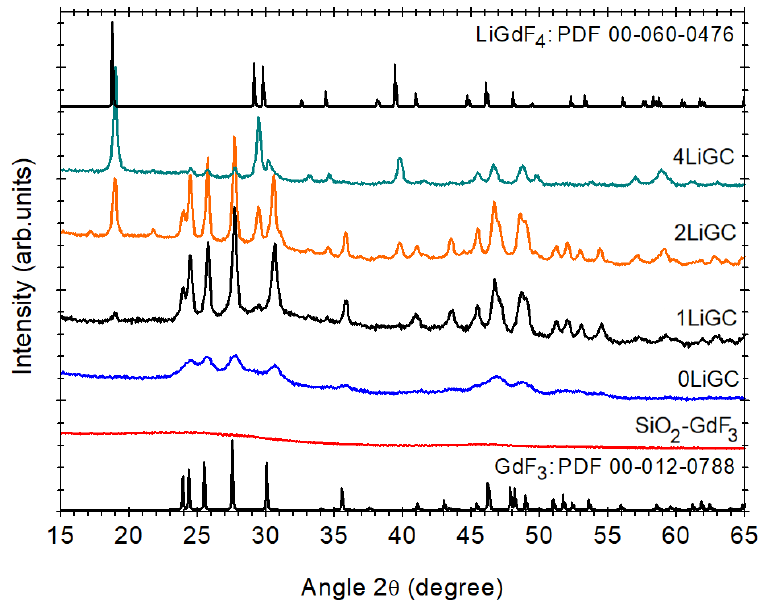
Figure 2. Normalized XRD patterns of SiO 2 -GdF 3 and Yb 3+ /Er 3+ -doped SiO 2 -GdF 3 (x2Li mol.%) nano-glass ceramic with different Li-ions doping levels; the PDF files of GdF 3 and LiGdF 4 are included.